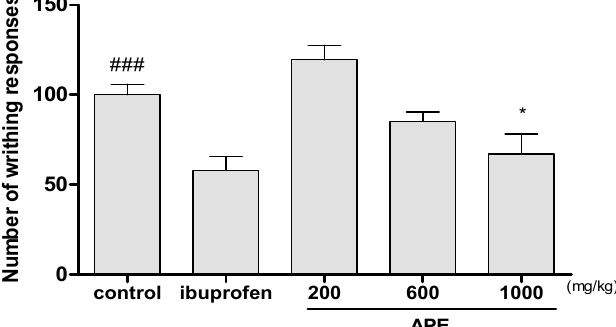
Figure 6. Effects of APE extract on writhing responses of acetic acid-induced Institute of Cancer Research (ICR) mice. After 30 min of oral administration, every mouse was intraperitoneally injected with 0.7% acetic acid before 10 min counting. The number of mice was 7–8 per group; ### p < 0.001 vs. ibuprofen, * p < 0.05 vs. control by one-way ANOVA, Dunnett’s test.